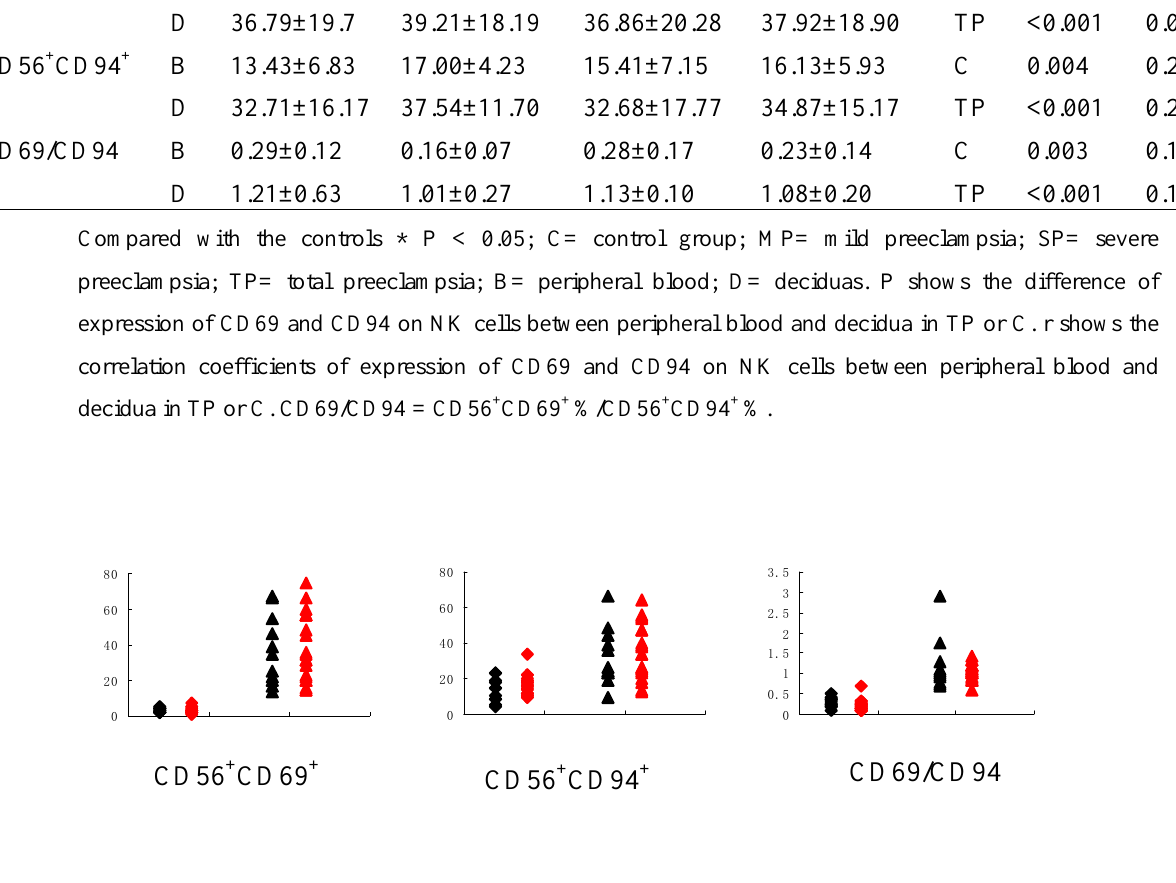
Figure 3. Individual percentages of NK cell receptors: CD69 and CD94 in lymphocytes and ratios of CD69/CD94 in preecalmptic patients and the controls. Rhombus, in blood. triangles, in deciduas. Black , the controls (n=11). Red , the preeclamptic patients (n =